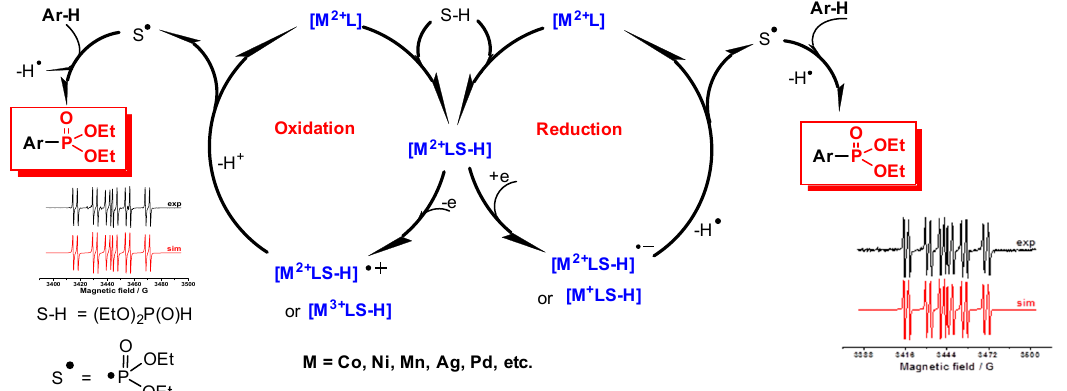
Scheme 5. Electrocatalytic phosphorylation of aromatic compounds under oxidation and reduction conditions (details of reactions for different metals are published in [33–39]).